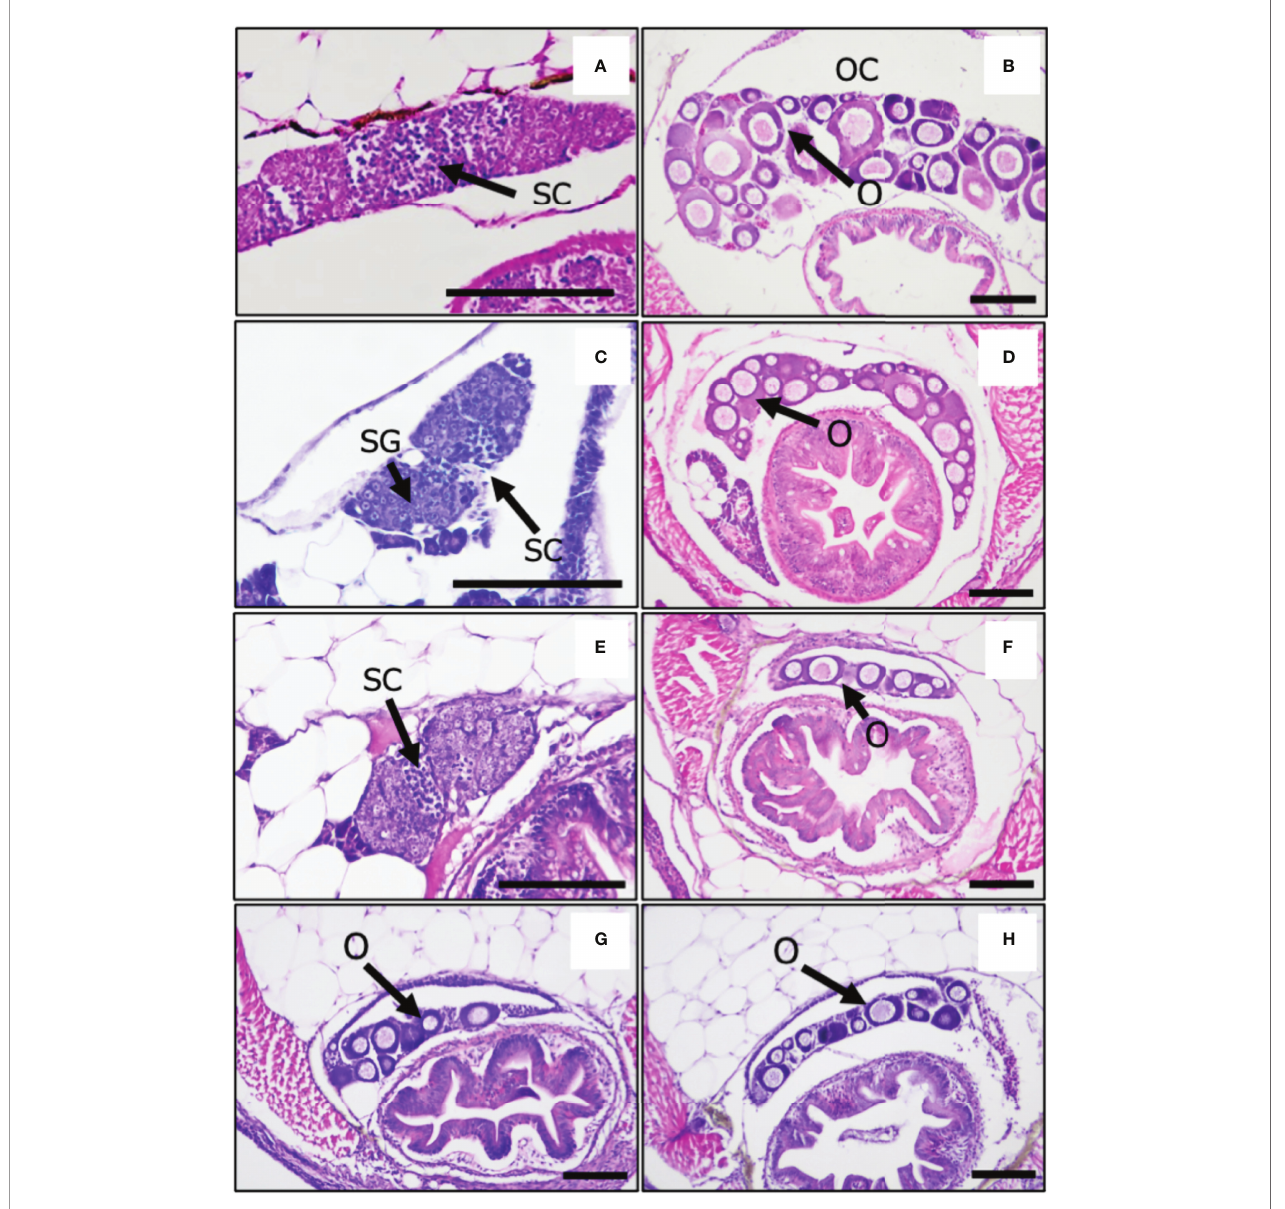
FIGURE 1 | Gonads of adult medaka at 2 months post-hatching. (A) XY male, control, (B) XX female, control, (C) sex-reversal XX male, (D) no sex-reversal XX female with